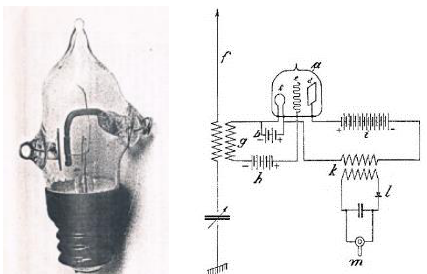
Fig. 1. Bronk's vacuum triode and a detector receiver circuit with a radio frequency amplifier on it. Patent of Bronk DRP271059 (1911).